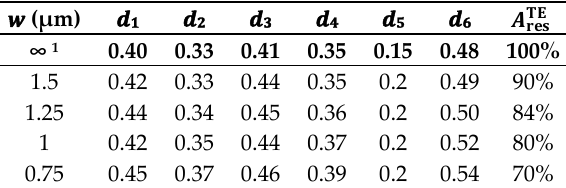
Table 1. Widths and absorption for the obtained optimized configurations and featuring different slab heights (cid:1875) from 0.75 to 1.5 µm. (cid:1875) = ∞ corresponds to the 1D VERTE